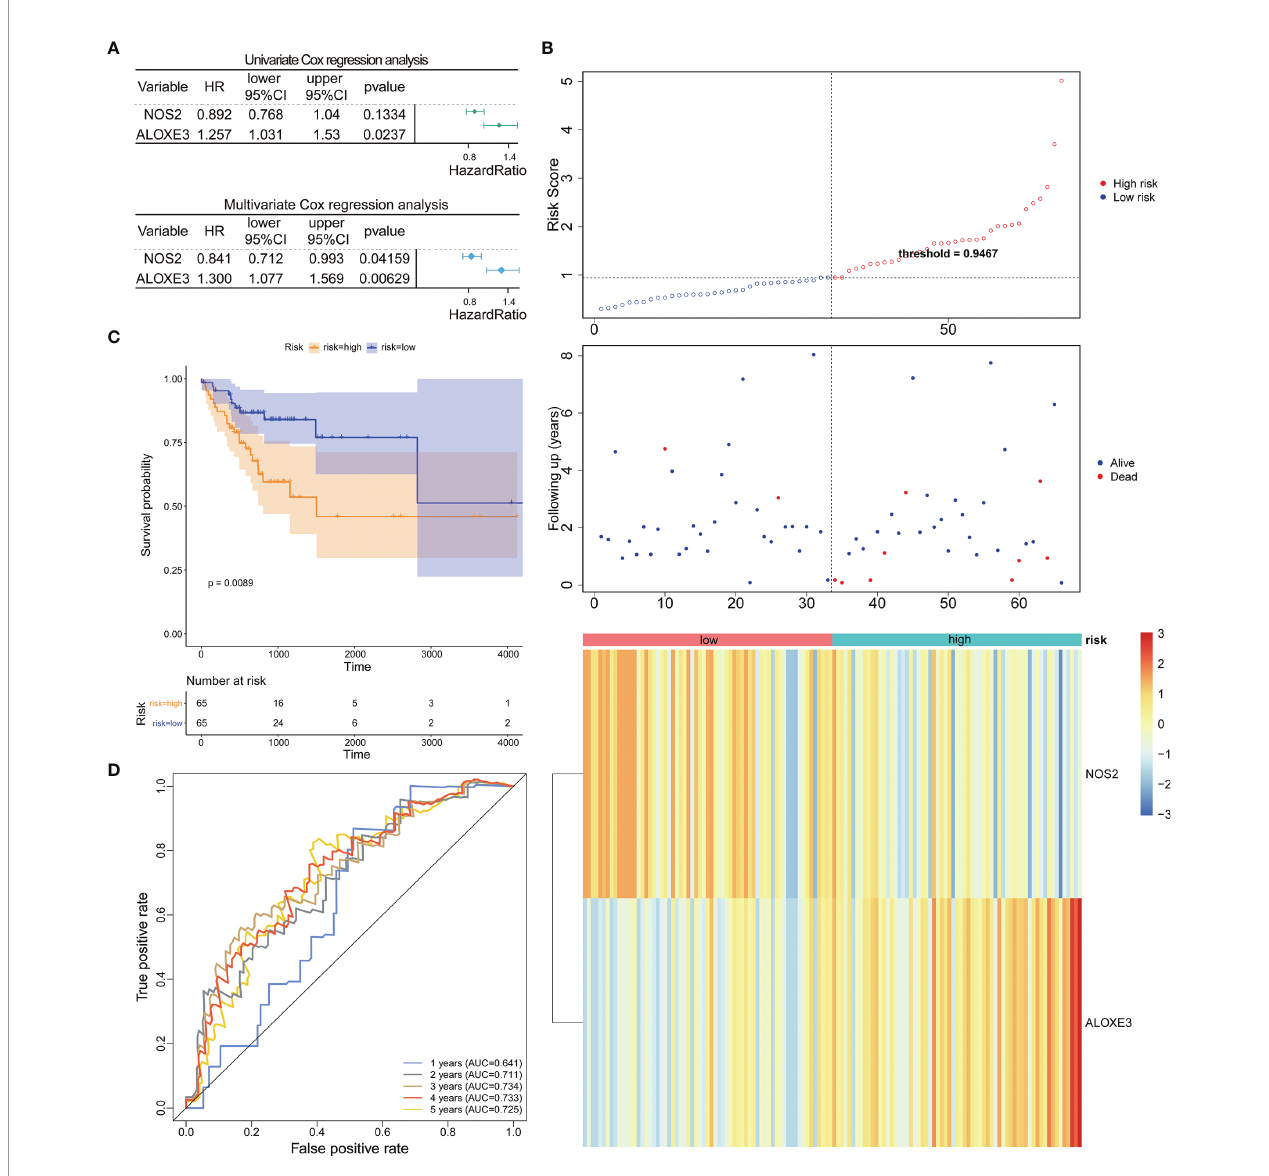
FIGURE 3 | Prognostic analysis of the 2-gene signature model in the RCRC-training cohort. (A) Forest plot of the relationship between DE-FRGs and OS of patients with RCRC by univariate (top) and multivariate (bottom) Cox regression analysis. (B) The Distributions of risk scores (top), survival statuses of patients in low ‐ risk and high ‐ risk groups (middle), and two ‐ gene expression pro fi les of each patient (bottom). (C) . Kaplan-Meier curves for the OS of patients in the high-risk group and low- risk group in the RCRC-training cohort. (D) The ROC analysis of RCRC-training cohort for survival prediction by DE-FRGs-based